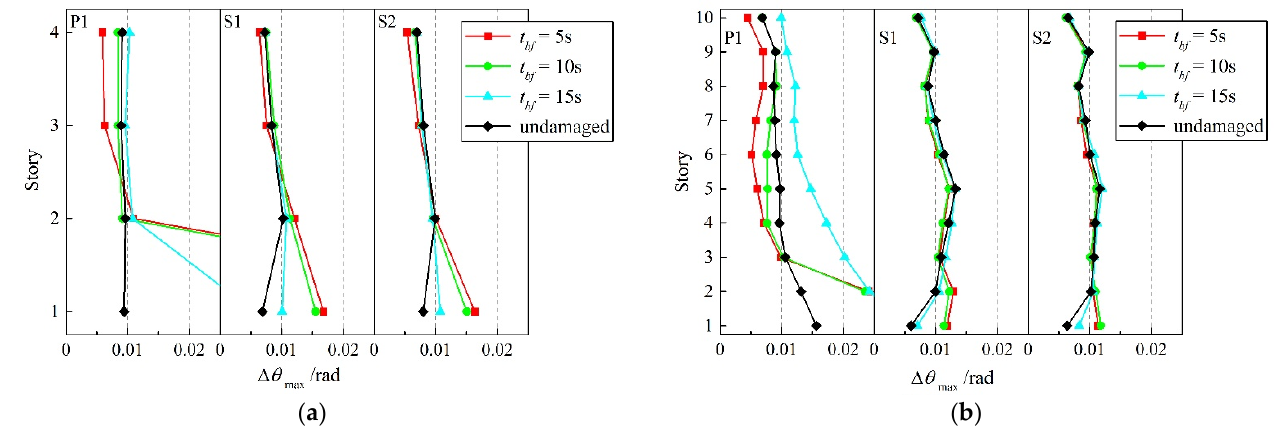
Figure 15. Δ θ max of residual structure after first-story brace fails. ( a ) 4-story; ( b ) 10-story.